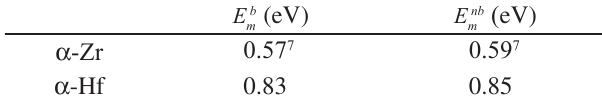
Table 2. Vacancy migration energy calculated by molecular